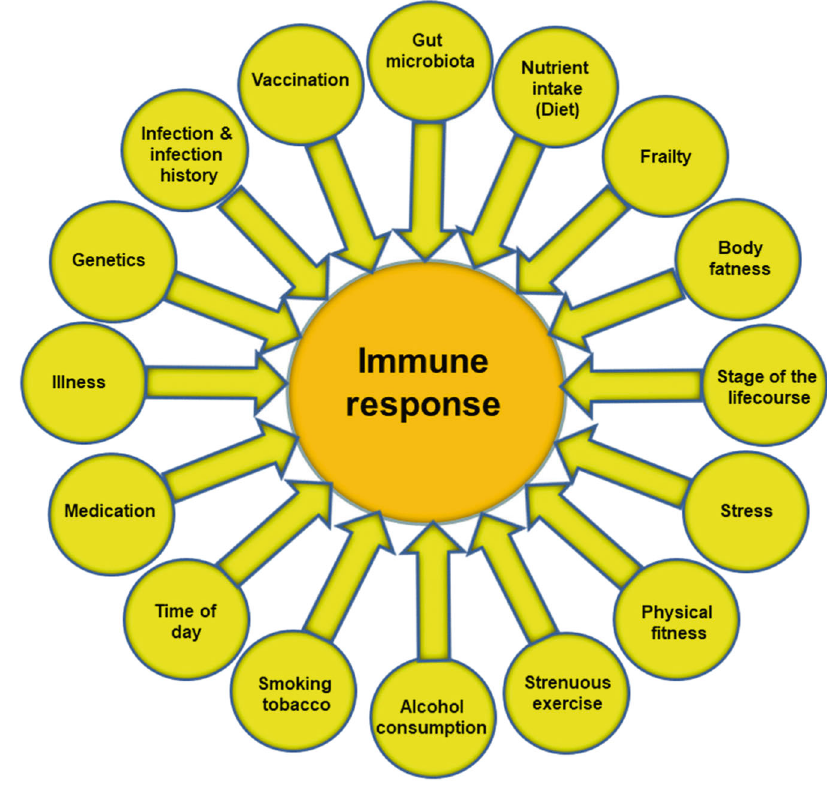
Fig. 3 Factors that in fl uence the immune response. Note that the listing is not